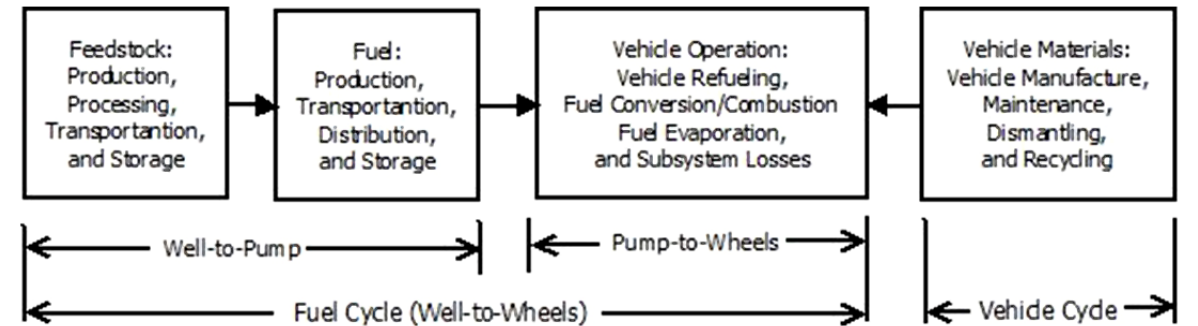
Figure 1. Lifetime energy consumption for transportation